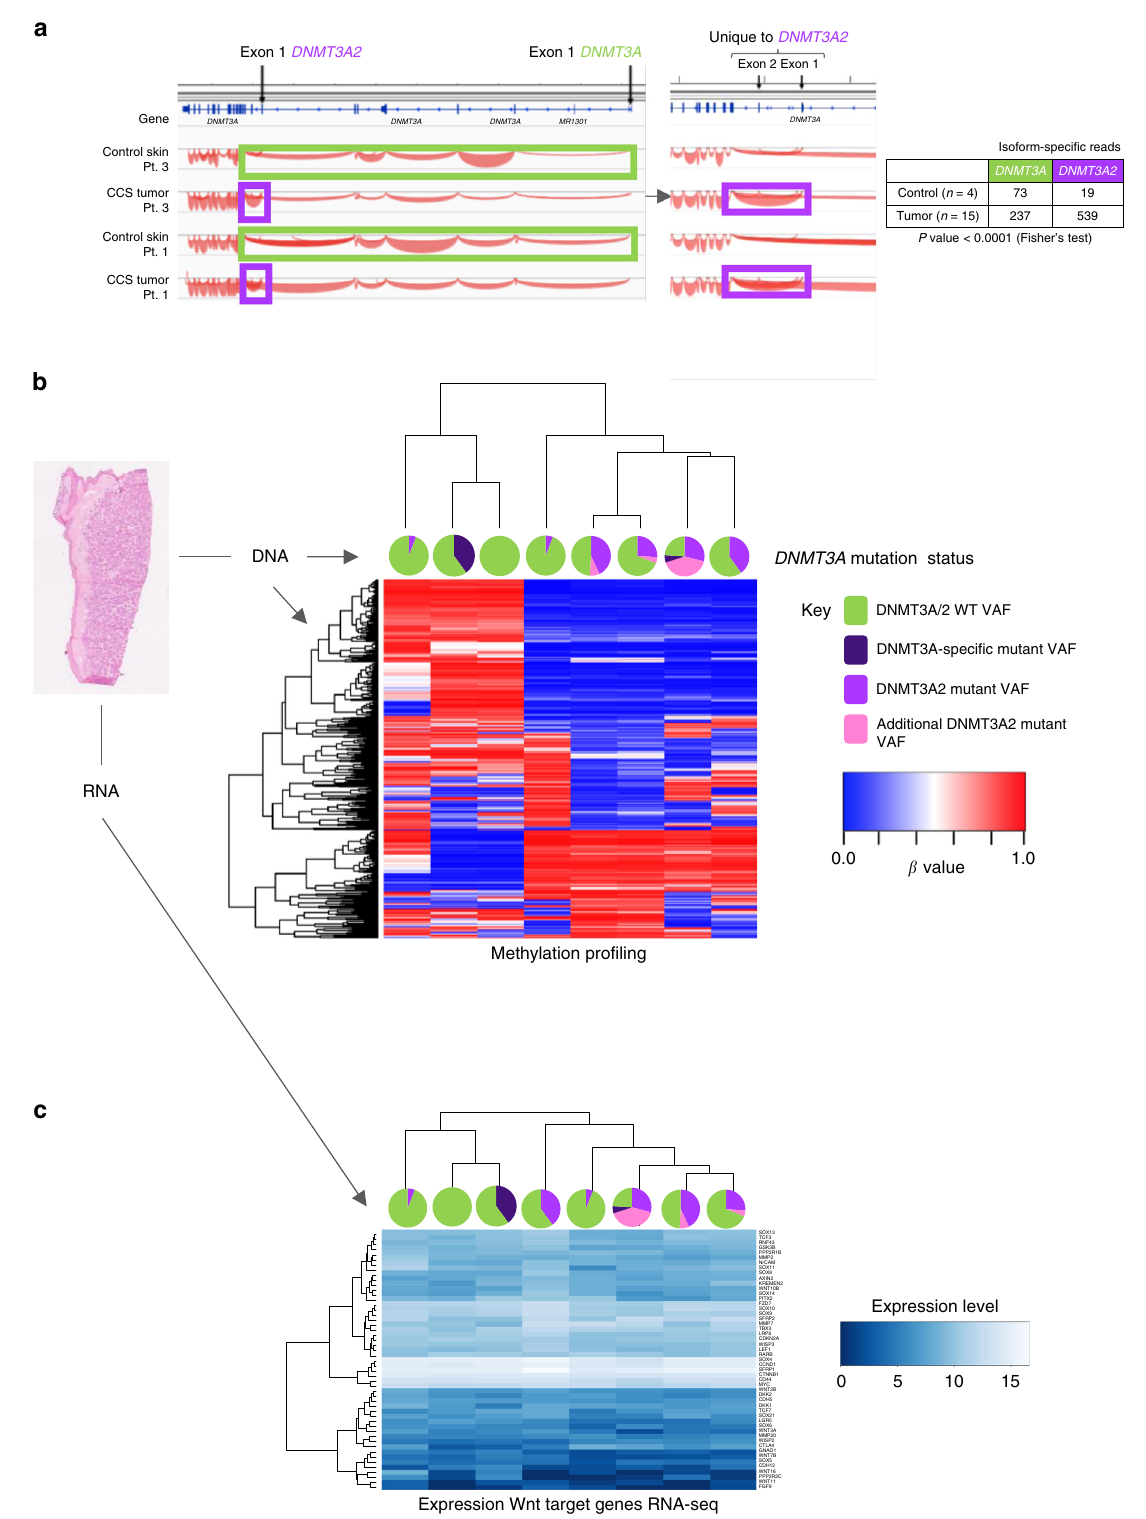
Fig. 3 DNMT 3 A 2 is overexpressed in CCS tumors. a RNA-sequencing of 15 CCS tumors revealed that the short isoform of DNMT3A , DNMT3A2 , is preferentially overexpressed in CCS tumors. b In a further eight CCS tumors, DNA and RNA were extracted from the same sections. Methylation pro fi ling, followed by unsupervised clustering of the 500 most variably methylated probes revealed two clusters ( DNMT3A mutant VAFs are indicated as pie charts; heatmap key demonstrates β -values; blue indicates a low β -value (hypomethylated) and red indicates a high β -value (hypermethylation). c Expression of Wnt- β -catenin target genes in the same samples demonstrate the same two clusters are distinguished by expression levels of these